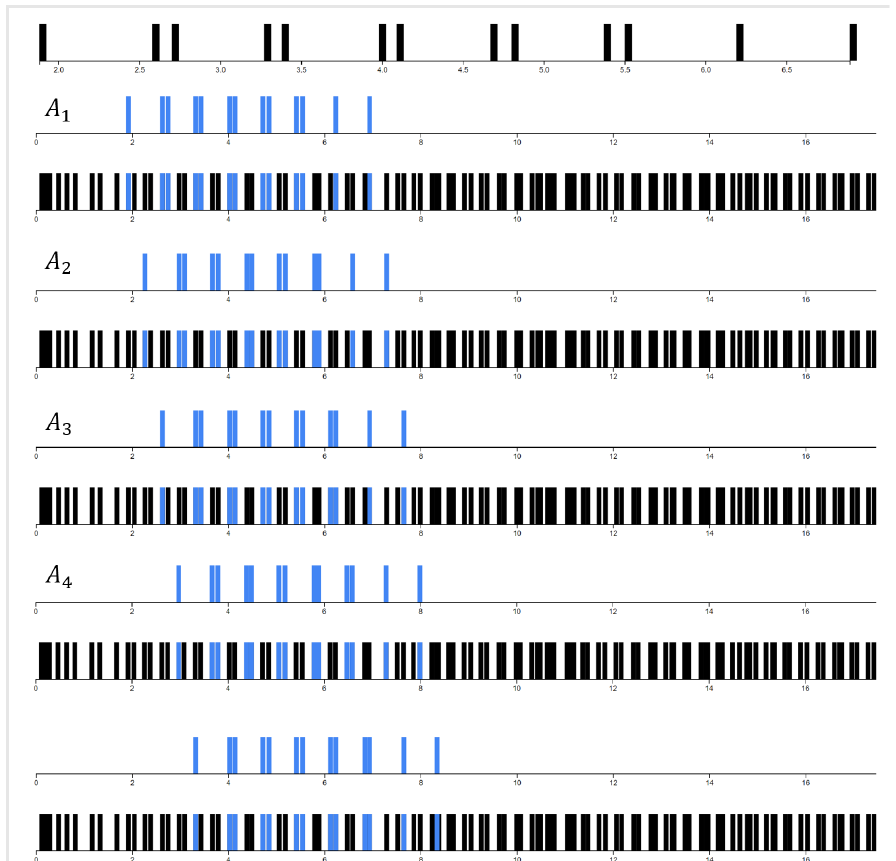
Figure 9. The L 5 part representing the basic swing rhythm commonly found in jive songs. Below the part’s structure, the first four activations are depicted individually with their projections onto the input layer. The decomposition of the part’s structure is shown in Figure 10.